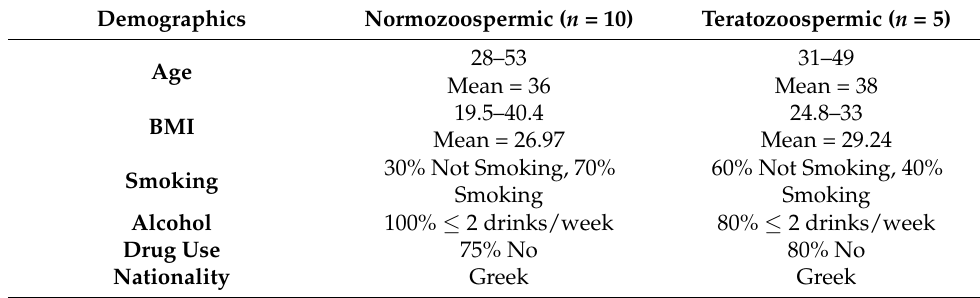
Table 1. Demographic information of volunteers selected to participate in this